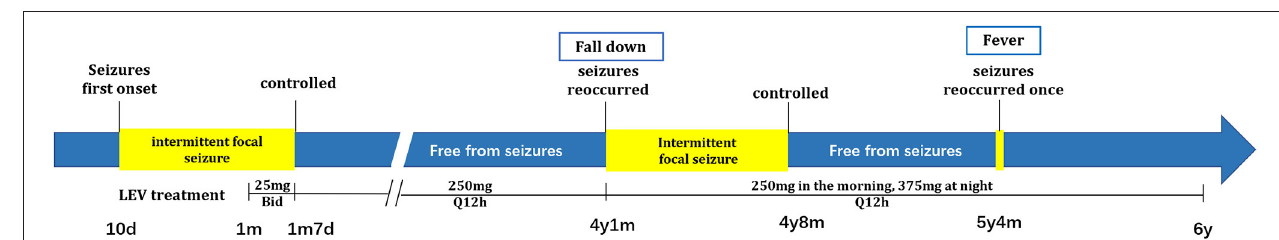
FIGURE 2 | Patient’s timeline of seizures and the following treatment. Patient’s seizures periods were highlighted in yellow. The dosages of LEV treatment are shown under the diagram of disease onset. // was used to omit the time intervals that have no changes in clinical display or